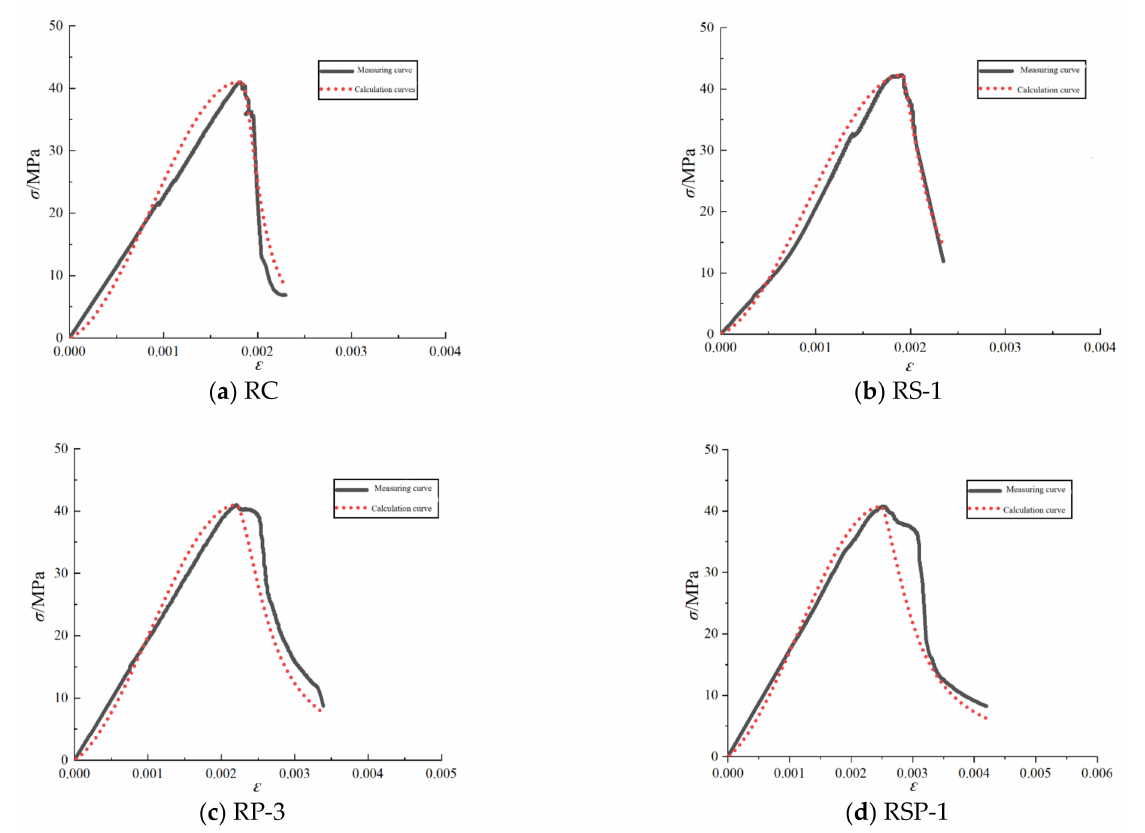
Figure 18. The comparison of stress–strain measuring curve and calculation